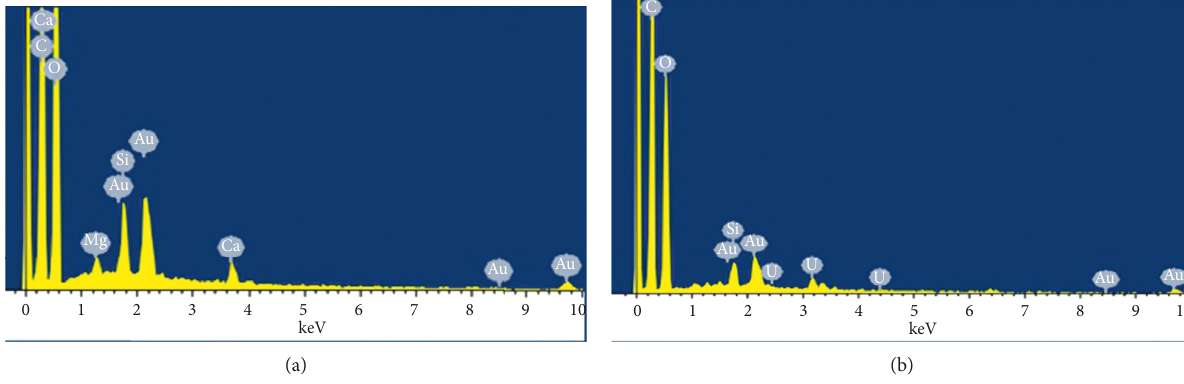
Figure 8: EDS analyses of modified rice stem: (a) before adsorption of uranium(VI); (b) after adsorption of